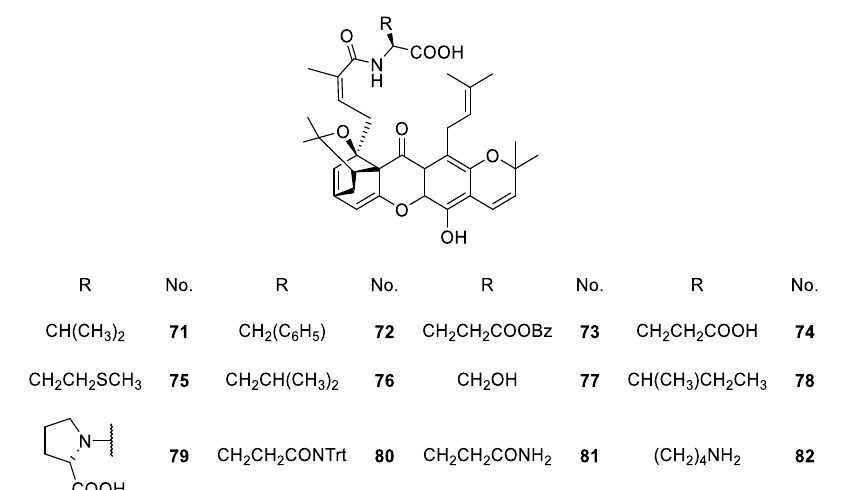
Molecules 2019 , 24 , x FOR PEER REVIEW Figure 9. Structures of caged xanthones 71 – 82 with antimicrobial activity. Figure 9. Structures of caged xanthones 71 – 82 with antimicrobial activity.